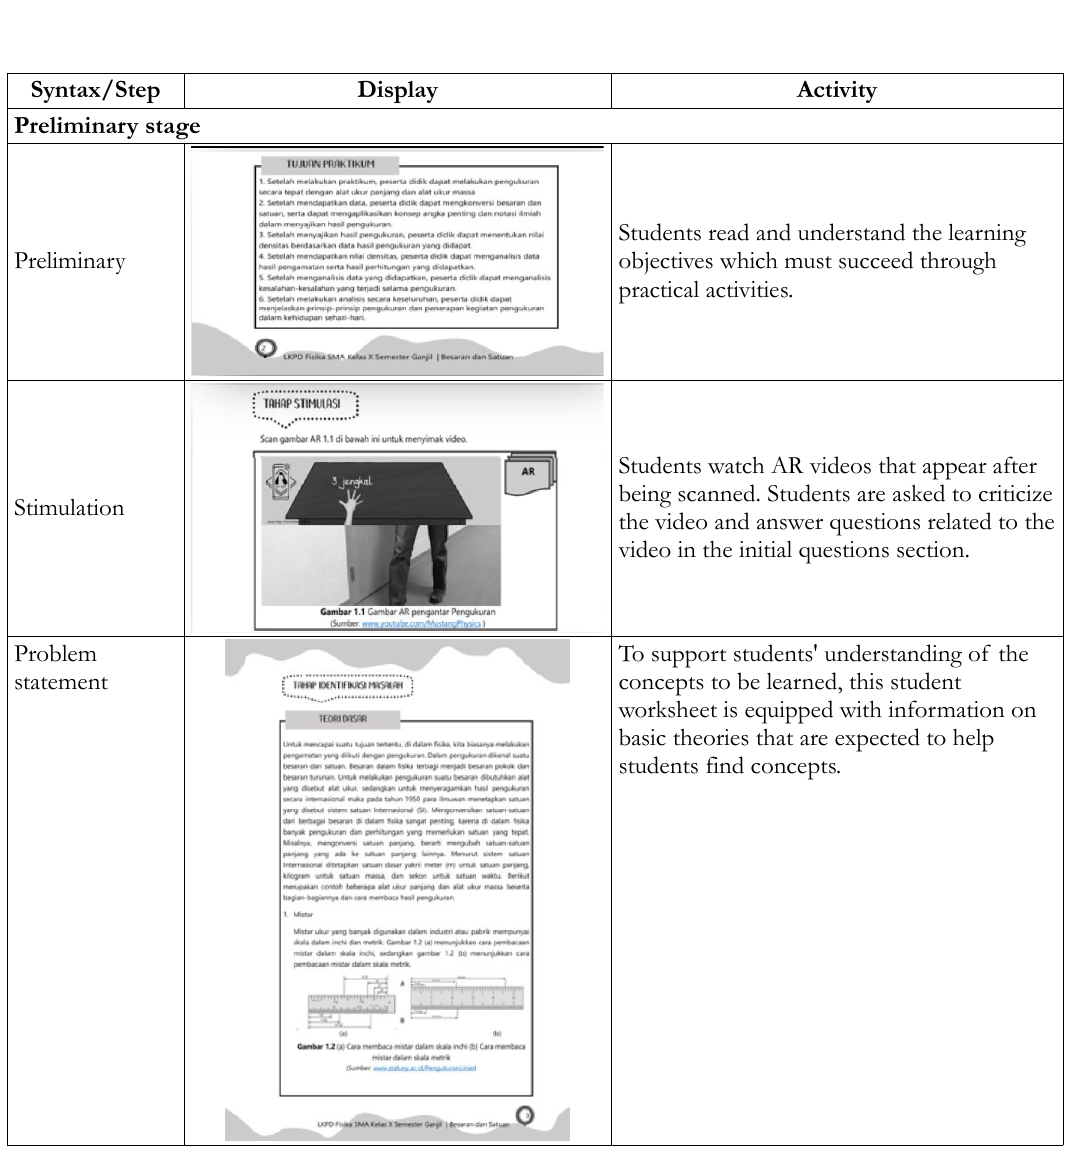
Figure 1. The cover view (a) front cover, (b) inside cover, (c) back cover of the student